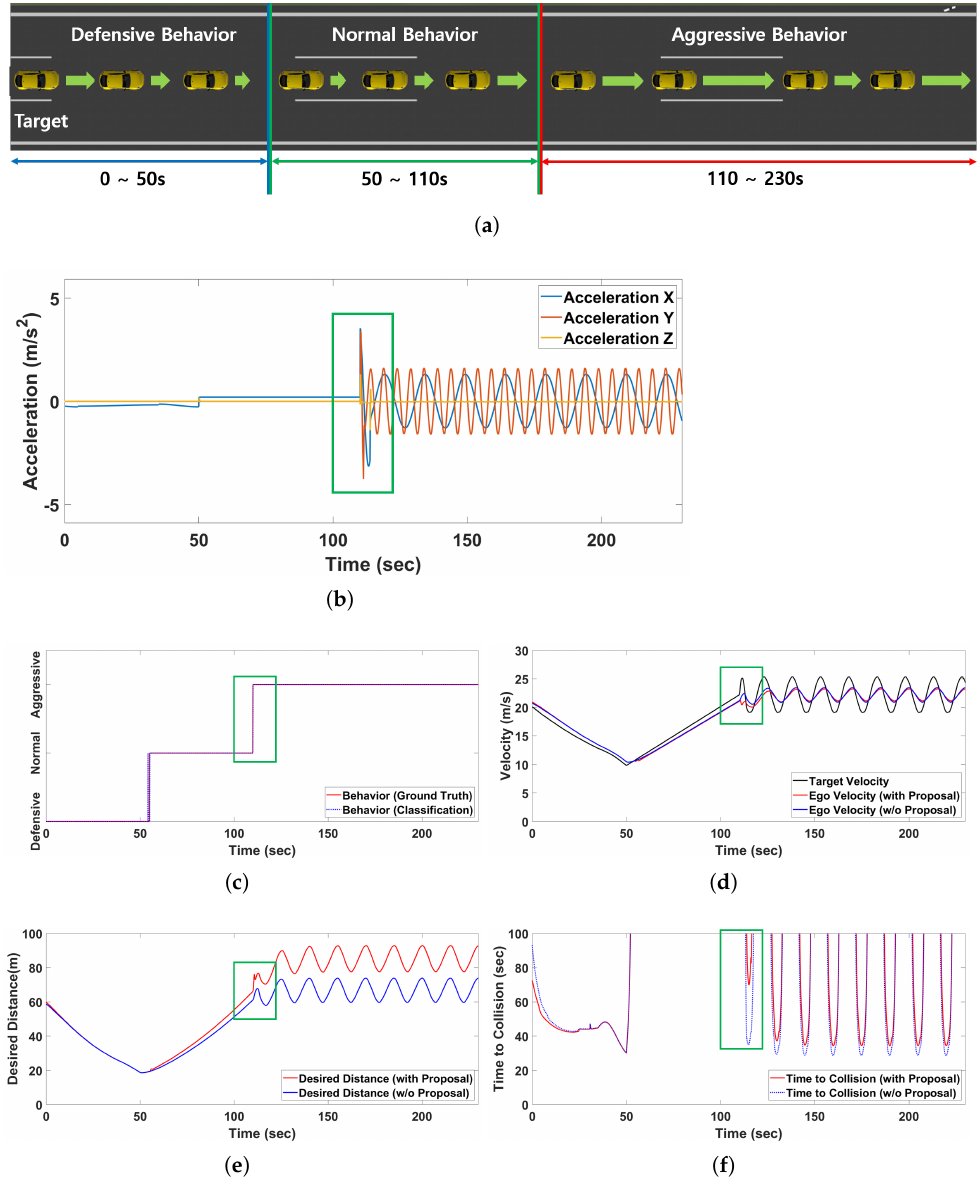
Figure 14. Experimental results of safety improvement of the proposed system in the ACC scenario: ( a ) ACC simulation environment. ( b ) Three-axis acceleration of the target vehicle. ( c ) Behavior classification results. ( d ) Driving velocity. ( e ) Desired distance. ( f ) Time to